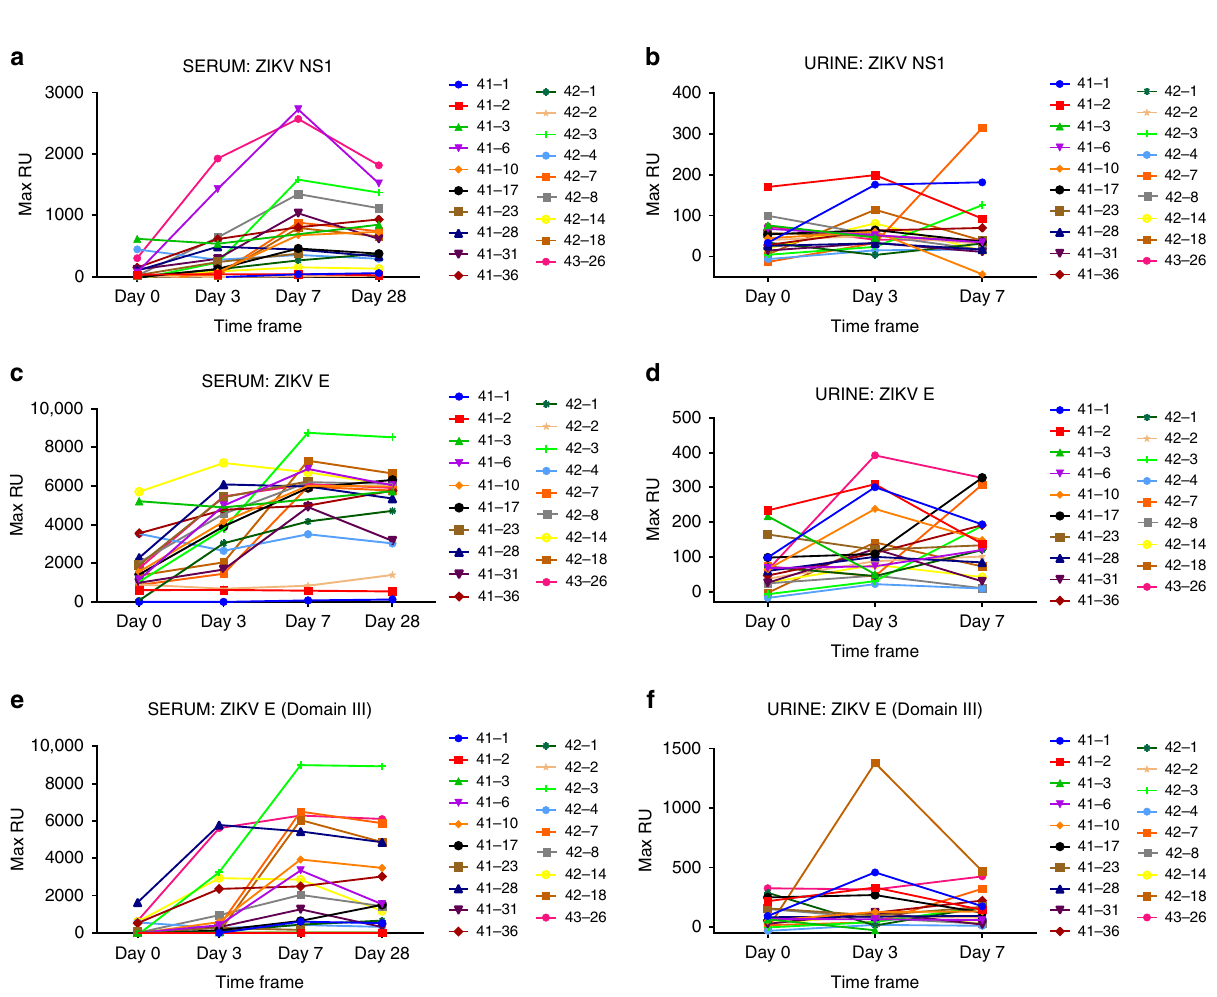
Fig. 5 Binding of Zika virus (ZIKV)-infected human serum and urine to NS1, E, and E-dIII in SPR. Serum ( a , c , d ) and urine ( b , d , f ) samples collected at different time points from adults post-ZIKV infection (days 0, 3, 7, and 28) were analyzed for total binding to puri fi ed NS1 ( a , b ), ZIKV-E ( c , d ), and ZIKV-E- domain III ( e , f ) proteins. Total antibody binding is represented in SPR resonance units. Maximum resonance unit (Max RU) values for protein binding by serum or urine antibodies obtained from each individual at different time point post-ZIKV exposure are linked by connecting lines. Source data are